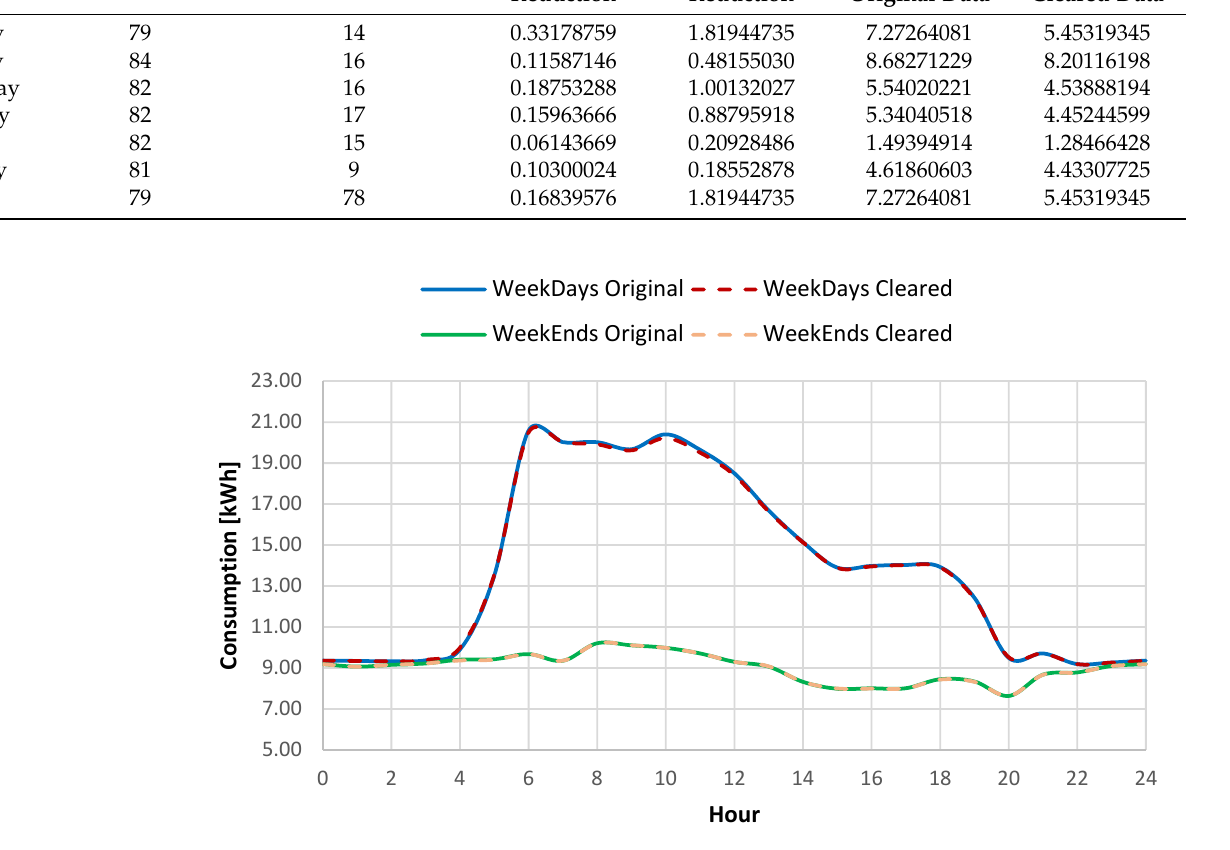
Figure 17. Daily consumption baseline for the original and cleared data sets.